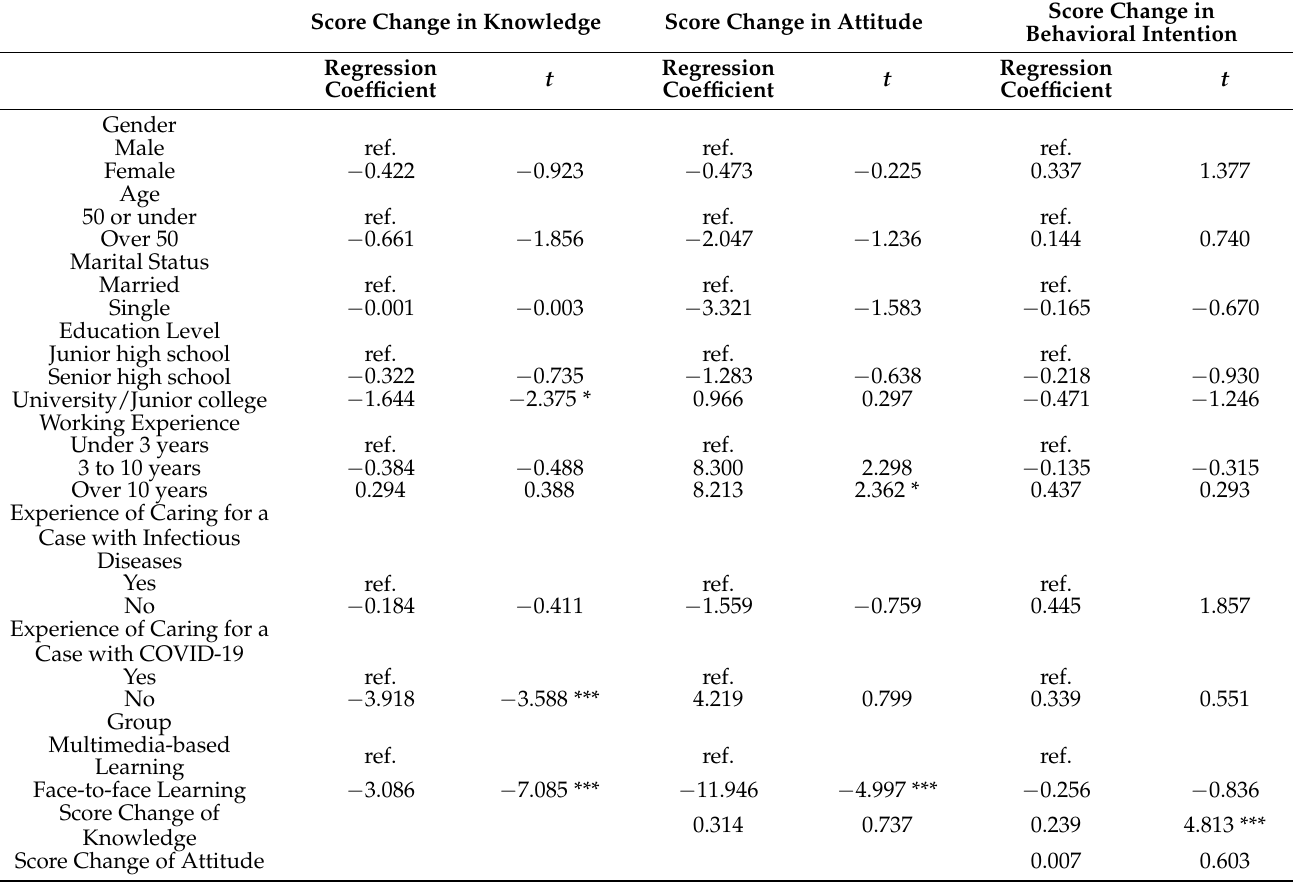
Table 4. Multiple linear regression analysis: exploring associated factors for the score changes in knowledge, attitude, and behavioral intention. Score Change in Knowledge Score Change in Attitude Regression Coefficient